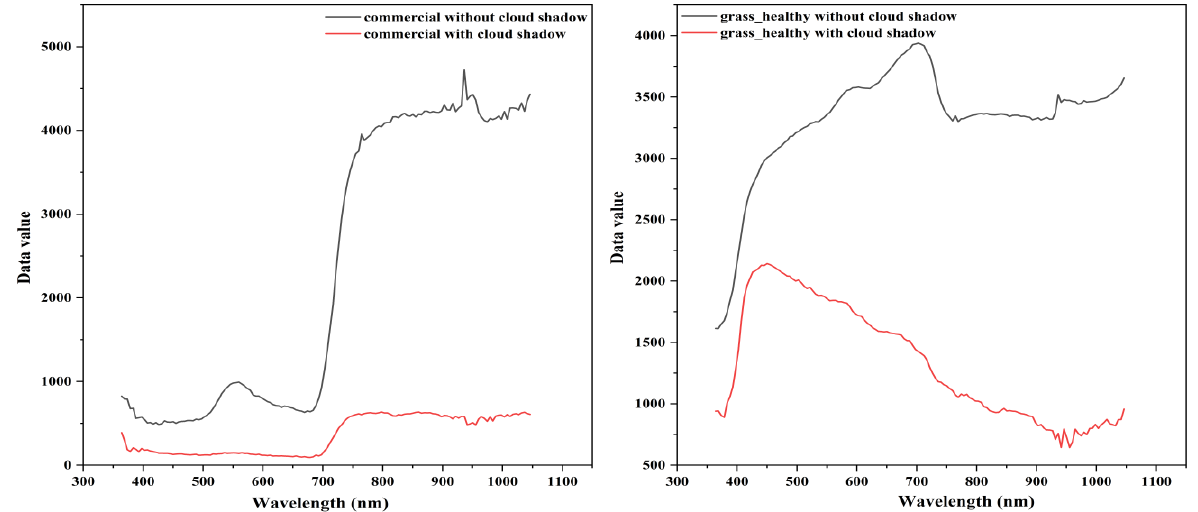
Figure 10. Comparison of spectral curves of the same class on Houston dataset. The ( left ) is the spectral curves of commercial , the ( right ) is the spectral curves of grass_healthy .